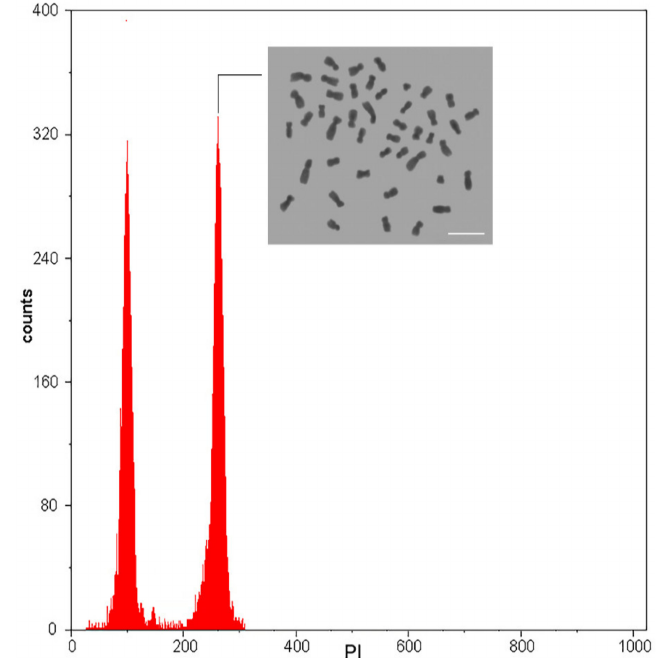
Figure 5. Nuclear DNA content and ploidy confirmation/chromosomal number of C. arabica seedlings regenerated in vitro. Representative histogram showing G0/G1 peaks of intact S. lycopersicum nuclei in channel 100 and ‘Catua í Vermelho’ or ‘Caturra’ in channel 262 and ploidy/chromosome number confirmation 2n = 4x = 44. Bar = 5 µ